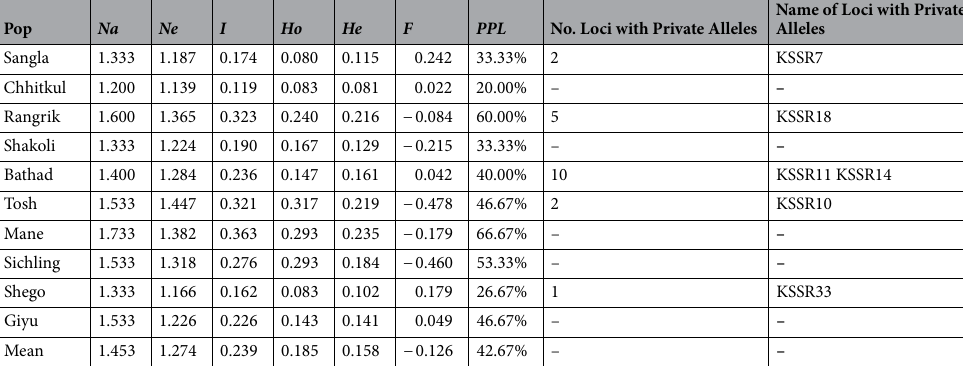
Table 2. Genetic variation parameters of the 10 populations of Dactylorhiza hatagirea collected from different regions of Himachal Pradesh. Na = Number of Different Alleles, Ne = Number of Effective Alleles, I = Shannon’s Information Index, Ho = Observed Heterozygosity, He = Expected Heterozygosity, F = Fixation Index, PIC = Polymorphic Information Content, PPL = Percentage of Polymorphic Loci, Fis = Inbreeding coefficient among individuals within